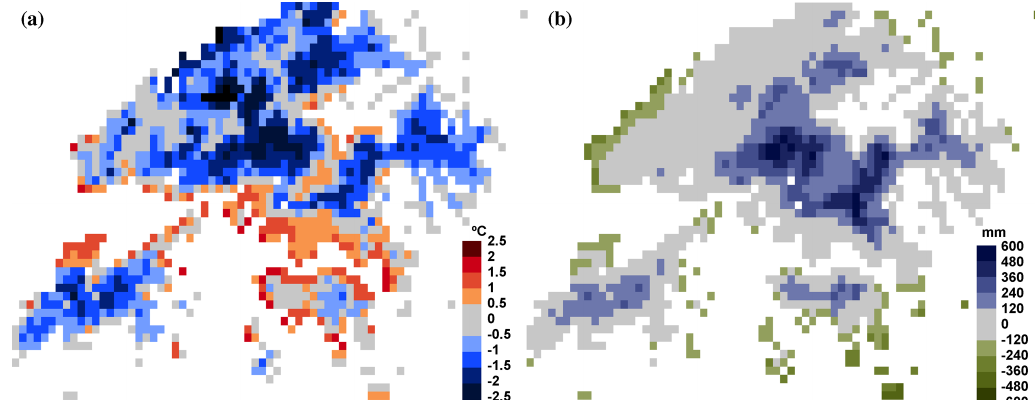
Figure 7. Differences between results of this study and WorldClim 2 (Fick and Hijmans, 2017) values. Panel (a) is average low temperature of the coldest month (bio6), with red where the local model is warmer than WorldClim, and blue is colder. Panel (b) shows annual precipitation (bio12), with blue where the local model predicts more rainfall than WorldClim, and tan is less rainfall. Our model results were resampled to 1km resolution using bilinear interpolation to allow for these